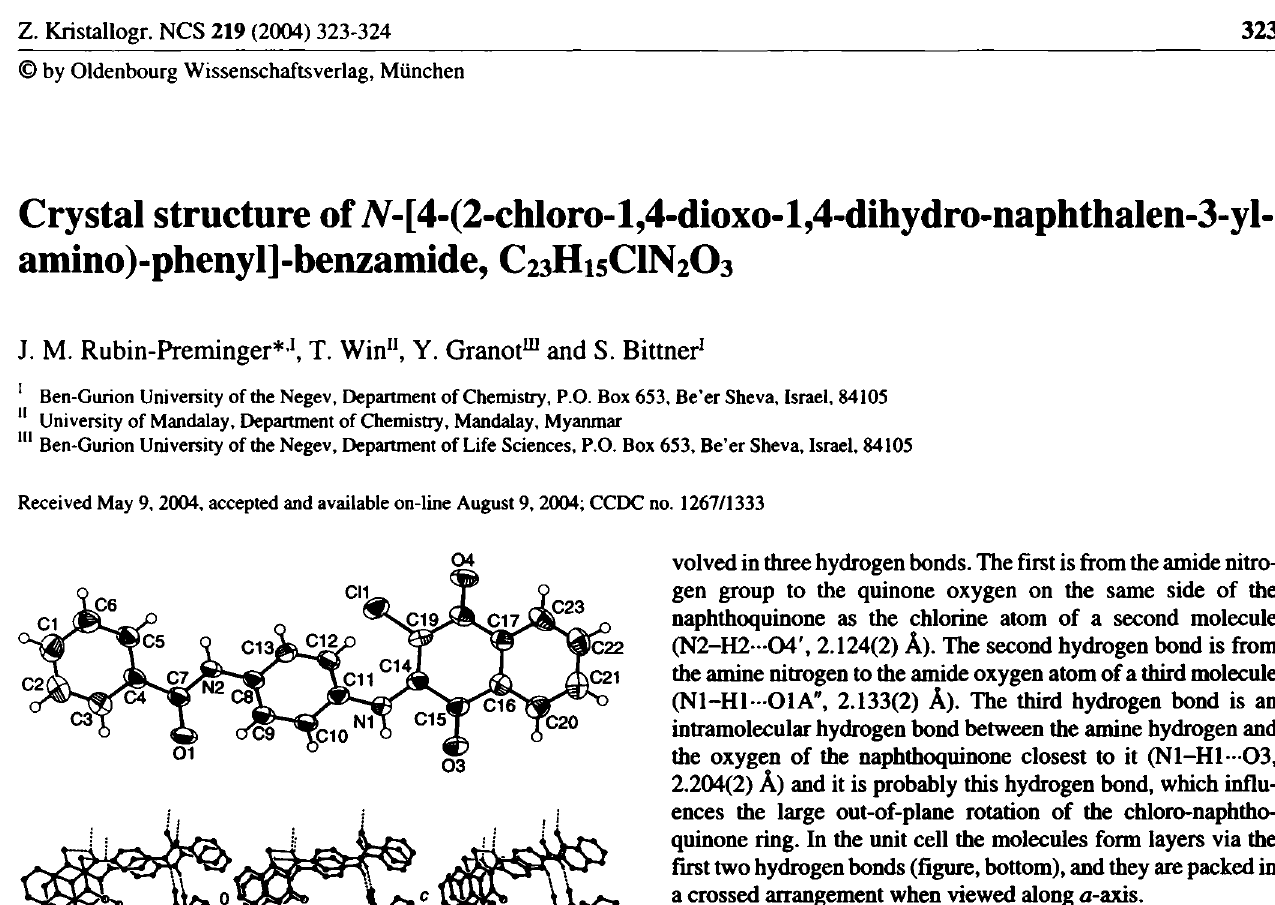
Table 1. Data collection and handling.